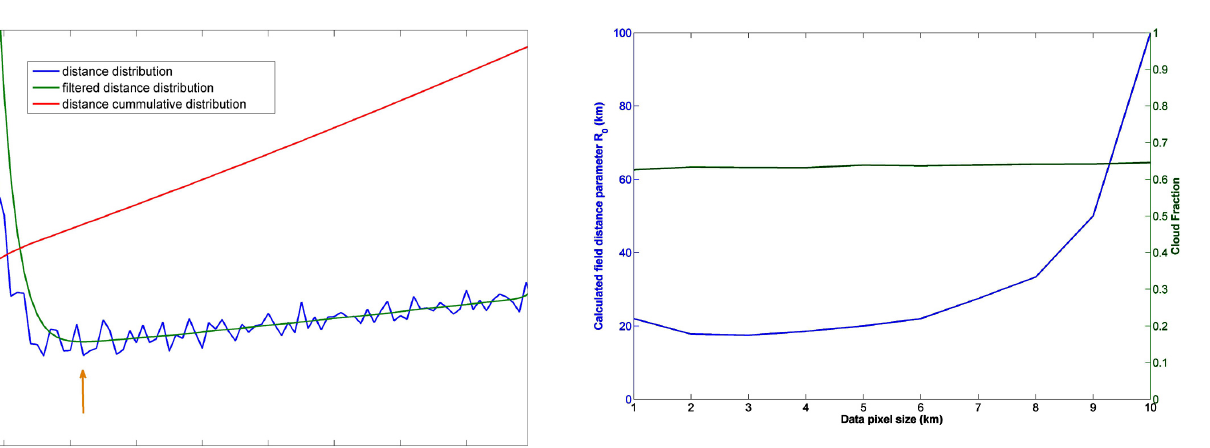
Fig. 3. The calculated field distance parameter R 0 (blue line) and the relative cloud fraction (green line), for varying resolution of MODIS